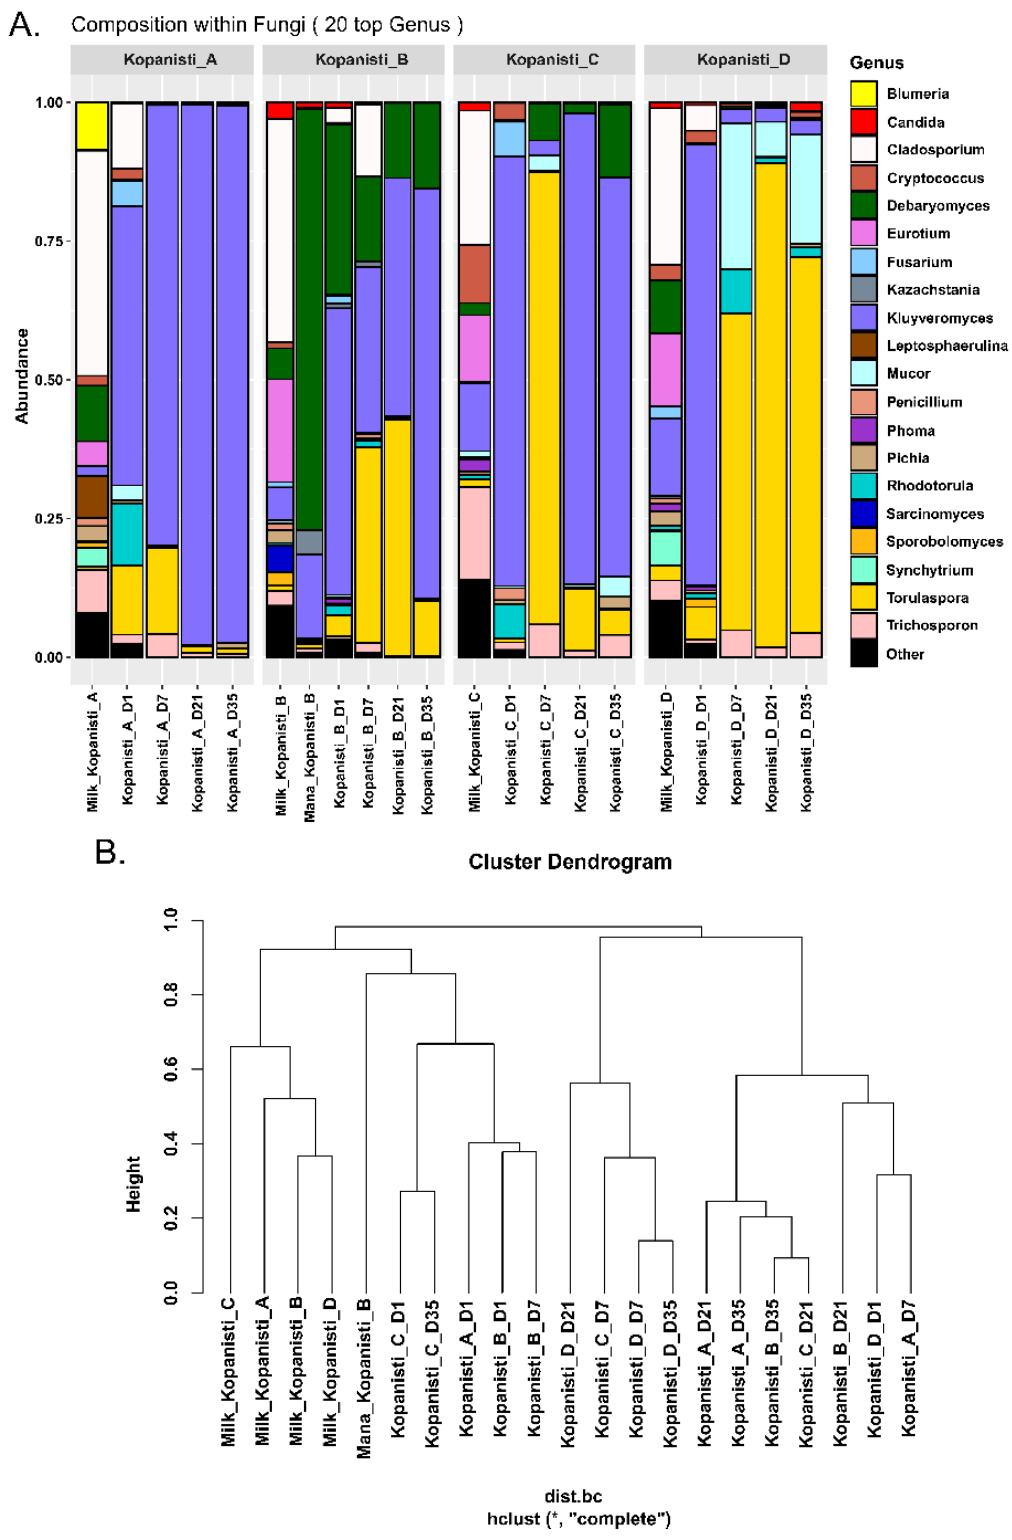
Figure 6. ( A ) Composition plots of the relative abundances of the 20 most abundant yeasts/fungi zOTUs taxonomically assigned at the genus level in pasteurized milk, Mana Kopanisti and Kopanisti cheese samples. Samples from each Kopanisti type (A–D) are presented together in subpanels. ( B ) Hierarchical clustering of the yeasts/fungi communities at the genus level identified in pasteurized milk, Mana Kopanisti and Kopanisti cheese samples.